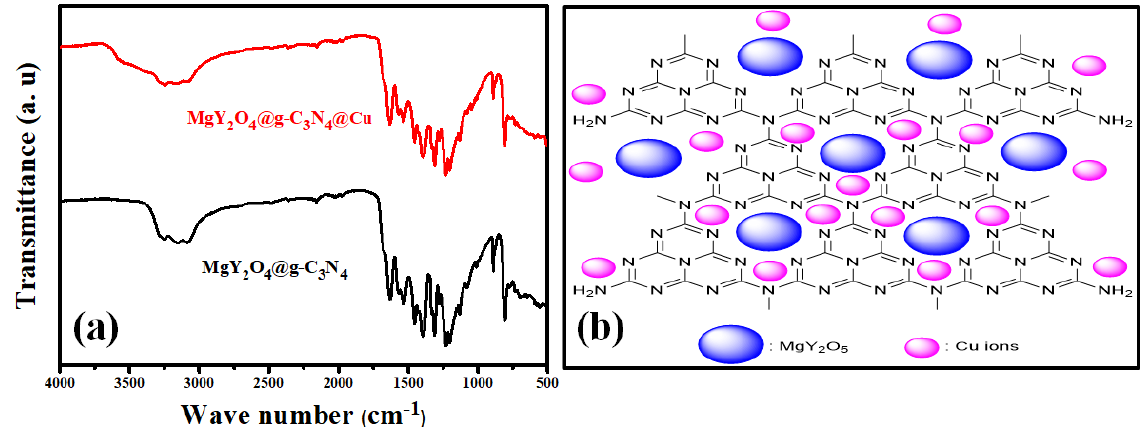
Figure 9. ( a ) FTIR spectra of MgY 2 O 4 @g-C 3 N 4 nanomaterials previously and after Cu (II) adsorption; and ( b ) proposed adsorption mechanism.